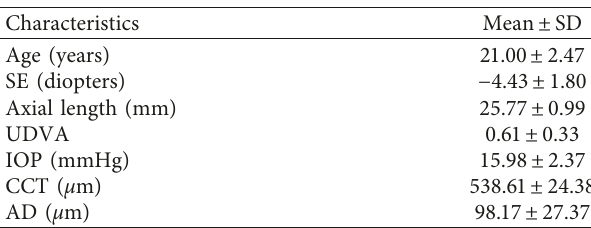
Figure 1: Optic coherence tomographic angiogram of the macular area and optic nerve from a 22-year-old male. (a) Foveal avascular zone (the area within the inner annulus). (b) Foveal area (the area within the inner circles) comprising the parafoveal area (the annulus between the inner and middle circles) and perifoveal area (the annulus between the middle and outer circles). The diameter of inner, middle, and outer circles is 1.0 mm, 3.0 mm, and 5.0mm, respectively. (c) Peripapillary (the annulus between the inner and outer circles). Table 1: Demographic